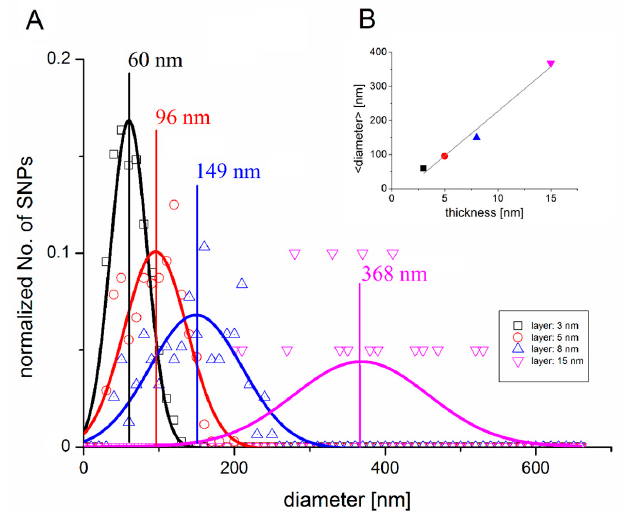
Figure 4. ( A ) Gaussian distribution of the average diameter of AgNPs; ( B ) linear relationship between average nanoparticle diameter and silver layer at T = 600 °C.